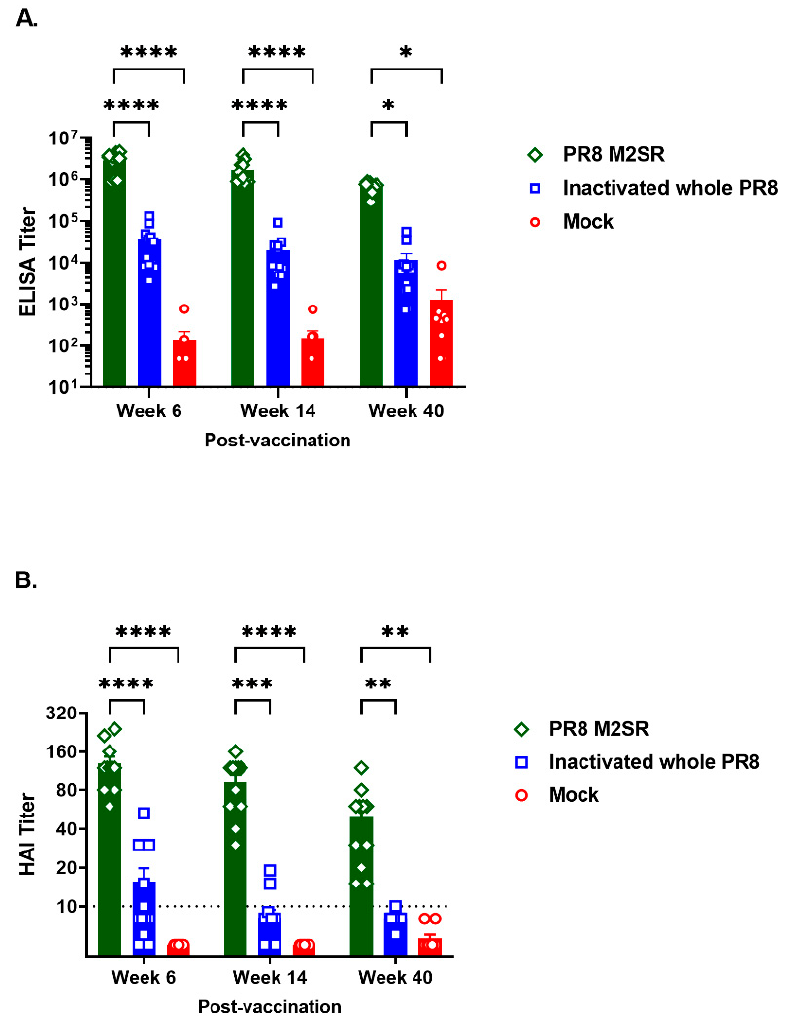
Figure 5. The duration of antibody responses to homologous influenza virus. The mice were vaccinated with M2SR-PR8 as described in the legend to Figure 4. The serum samples were collected 6, 14, and 40 weeks later for the ELISA and hemagglutination inhibition assays (HAI). ( A ) ELISA titers against whole inactivated PR8 virus (Charles River). M2SR-PR8 was significantly different than inactivated PR8 and mock groups; ****, p < 0.0001; *, p < 0.05 (two-way ANOVA). ( B ) HAI titers against PR8 virus. The HAI titers for M2SR-PR8- vaccinated mice were significantly different from those for inactivated PR8-vaccinated and mock groups; ****, p < 0.0001; ***, p ≤ 0.0003; ** p ≤ 0.003 (two-way ANOVA).